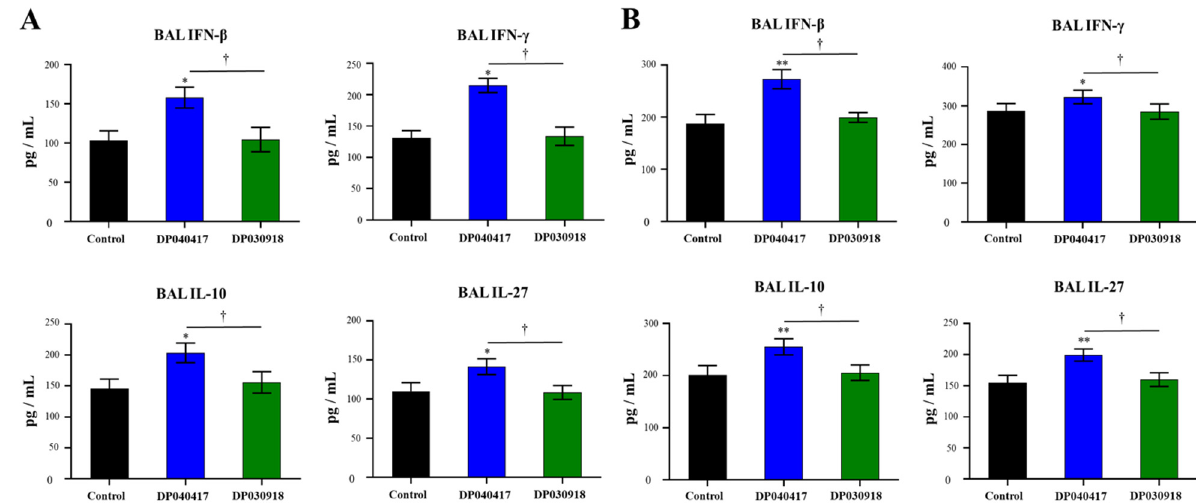
Figure 7. Effect of the respiratory commensal bacteria Dolosigranulum pigrum on the alveolar macrophages’ cytokine production. Infant mice were nasally primed with viable D. pigrum (DP) strain 040417 or 030918 during 5 consecutive days at a dose of 10 8 bacterial cells/mouse/day. One day after the last administration of DP, alveolar macrophages were harvested and cultured for 24 h. The levels of interferon (IFN)- β , IFN- γ , interleukin (IL)-10, and IL-27 (pg/mL) in culture supernatants were determined after the 24 h of culture ( A ) or after 24 h of the in vitro challenge with Streptococcus pneumoniae ( B ). Cells from non-treated infant mice were used as controls. The results represent data from three independent experiments ( n = 6 per each group at each time point). Significantly different when compared with control, * p < 0.05 or ** p < 0.01. Significantly di ff erences between the indicated groups, † p < 0.05.